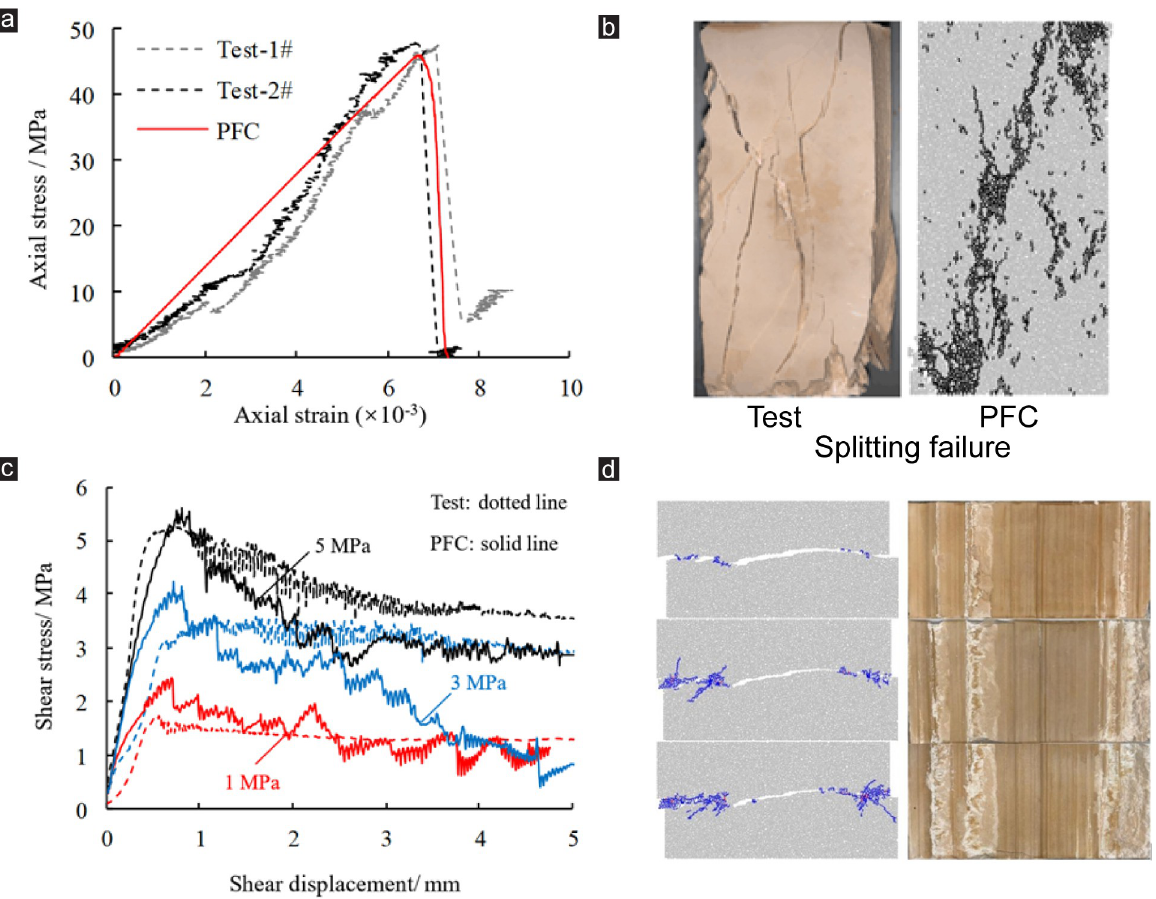
Fig 2. Check of parameters: (a) and (b) are uniaxial compression tests, (c) and (d) are CNS shear tests.